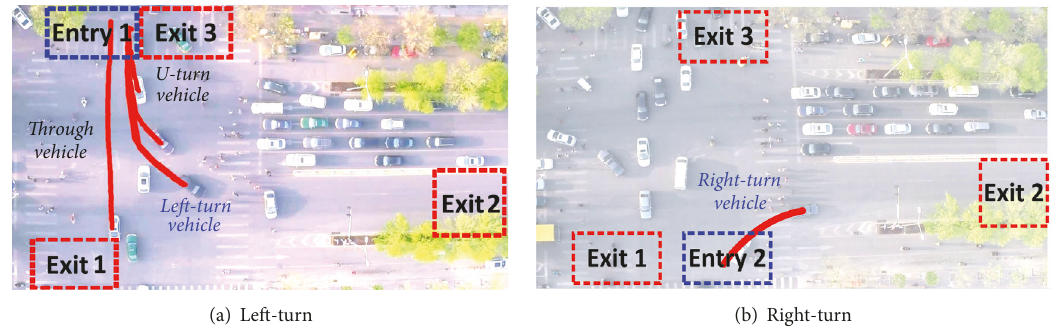
Figure 2: The configuration of entry and exit regions for turning vehicles.